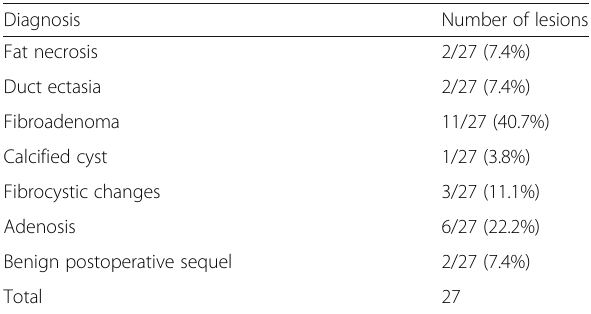
Table 1 The distribution of different pathological entities within the “ benign lesions ” group Diagnosis